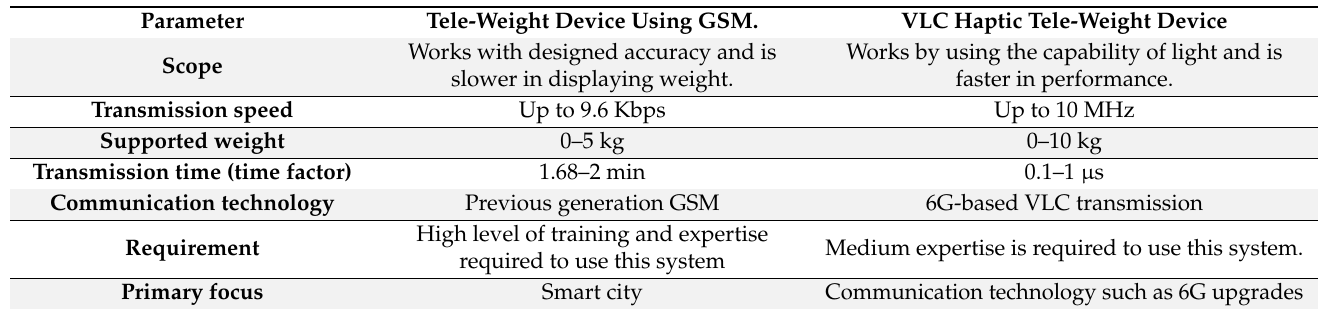
Table 1. Comparison between the current and the previously created system.